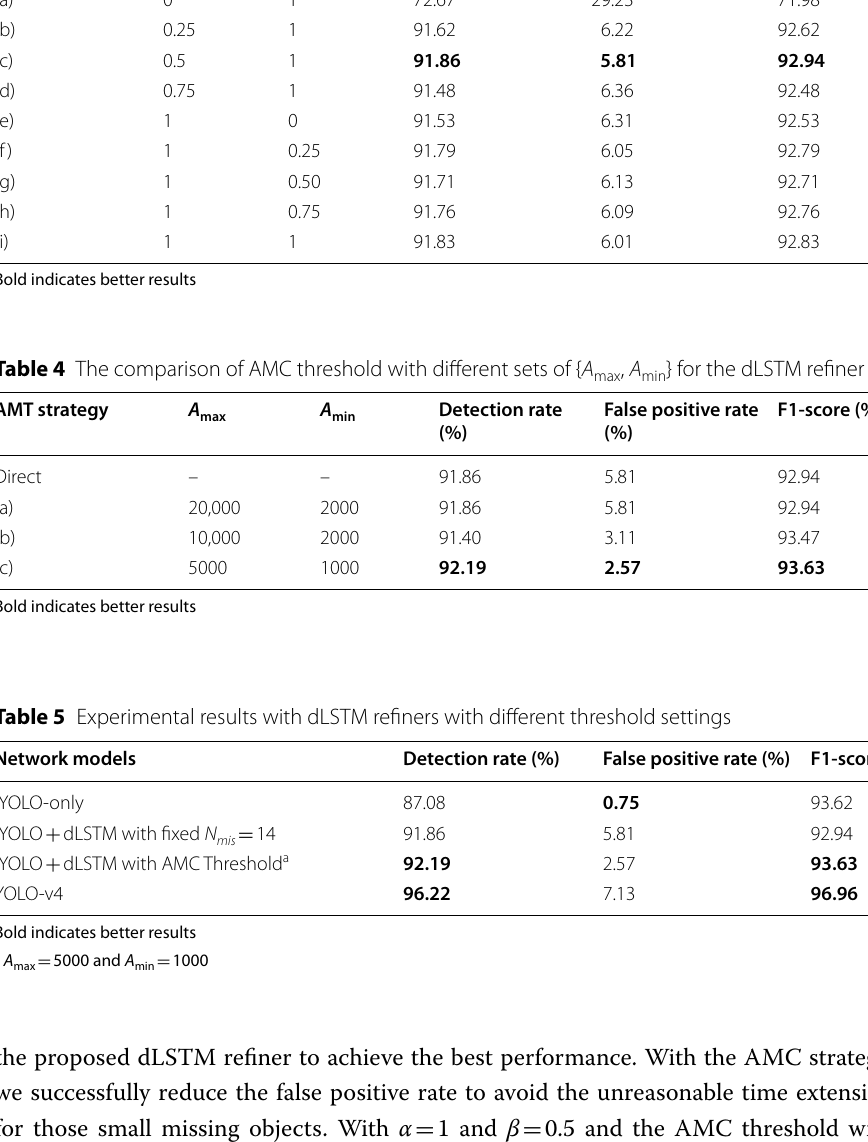
Table 3 The comparison of different α and β weighted in training the dLSTM Tracker based on the iYOLO results Test case